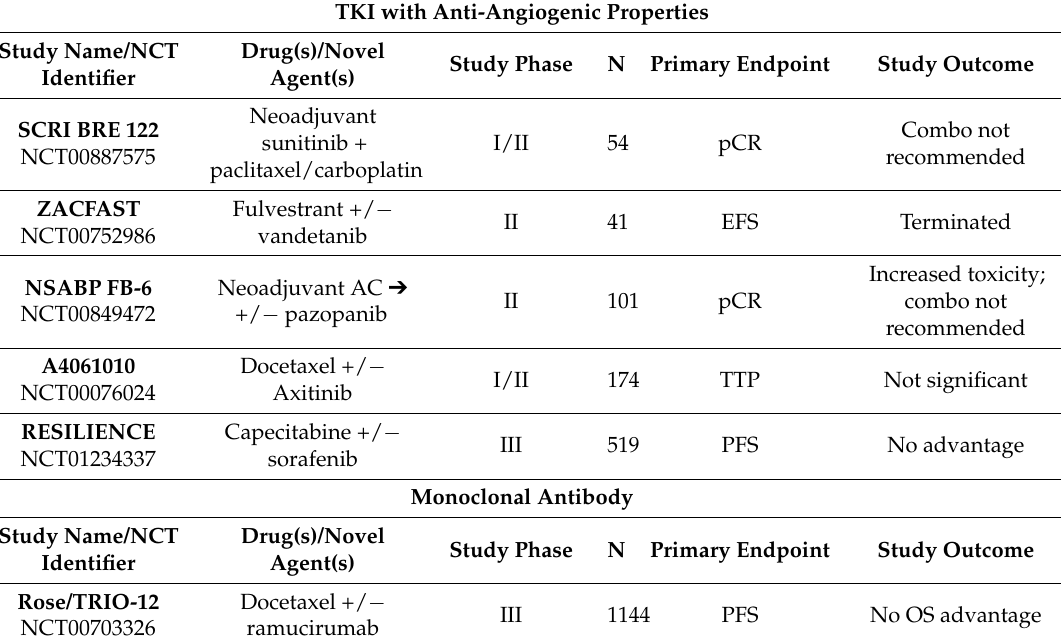
Table 3. Trials with Angiogenesis Inhibitors for Breast Cancer [16]. TKI with Anti-Angiogenic